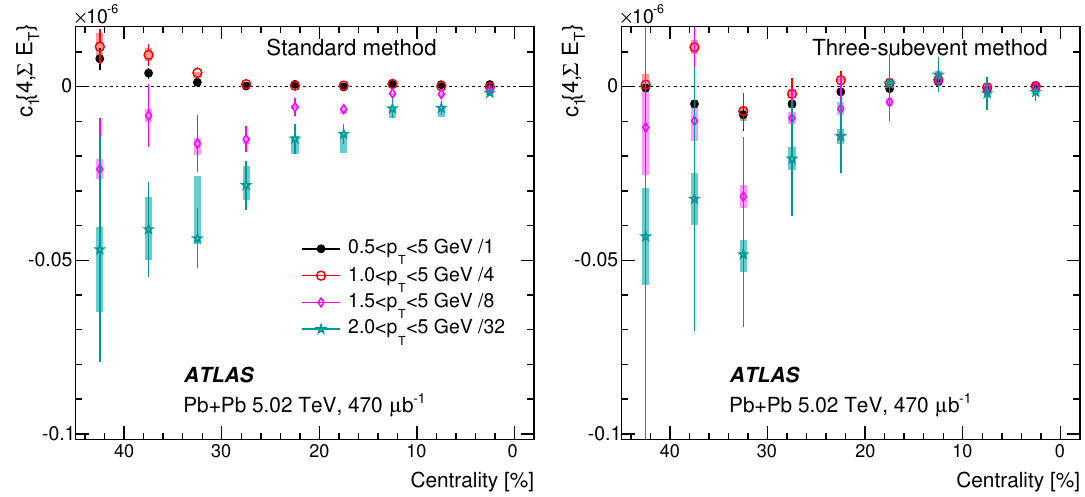
Figure 8 . The centrality dependence of c 1 f 4 g calculated for charged particles in several p T ranges with the standard method (left panel) and three-subevent method (right panel). The error bars and shaded boxes represent the statistical and systematic uncertainties, respectively. The data for each p T range are scaled by a constant factor indicated in the legend for the purpose of presentation. Zero is indicated by a dotted